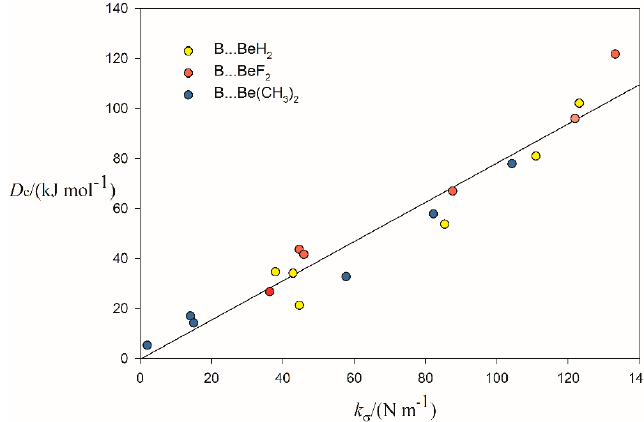
Figure 6. Variation of ab initio-calculated values of D e with k σ for 18 B ··· BeR 2 complexes (R = F, H or CH 3 ; B = CO, HCN, H 2 O, NH 3 , H 2 S or PH 3 ). For the linear regression, R 2 = 0.939.